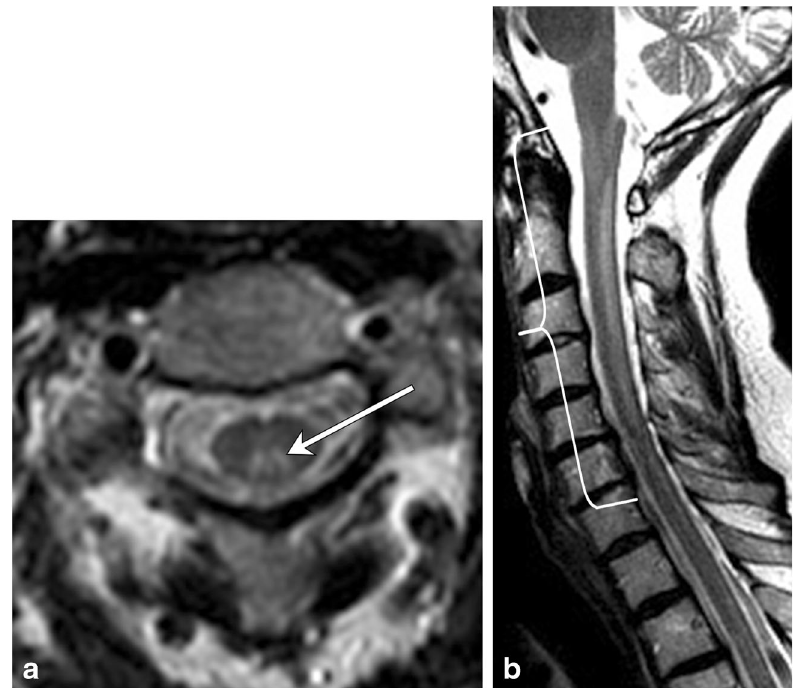
degeneration due to copper deficiency. A 45-year-old female with tingling in the bilateral upper and lower extremities. a Axial T2 image shows hyperintensity in the dorsal columns in an ‘ inverted-V ’ configuration (arrow). b Sagittal T2 image demonstrates long- segment T2 hyperintensity within the dorsal cord